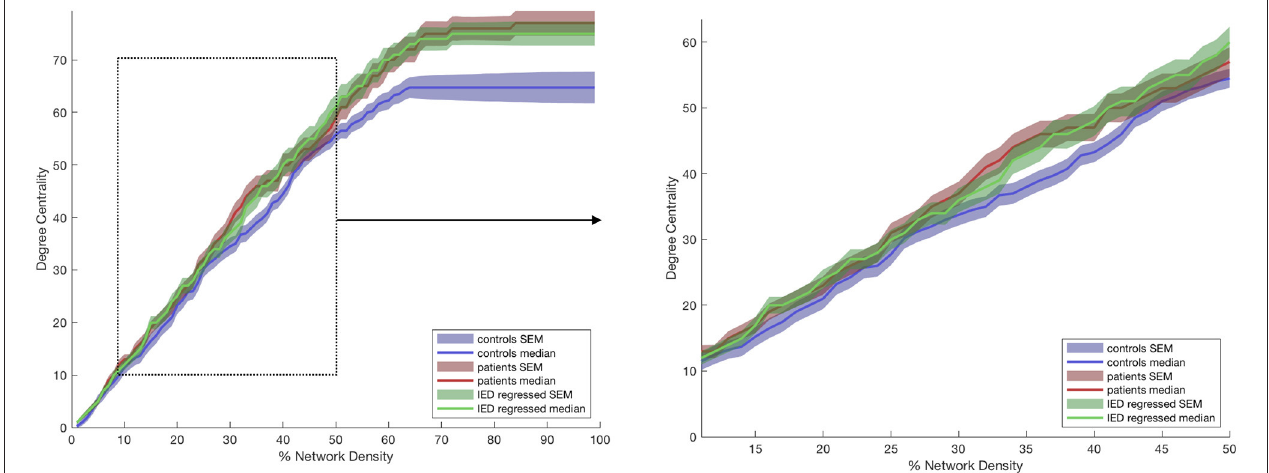
FIGURE 2 | Degree centrality of the anterior thalamic subregion ipsilateral to the epileptogenic zone (EZ). The lines represent controls (blue), patients before (red) and after (green) correction for interictal epileptiform discharges (IEDs). The left graphs show the full range of network densities from 0 to 100%. The dotted box shows the range selected for statistical analysis and shown in the right graph.